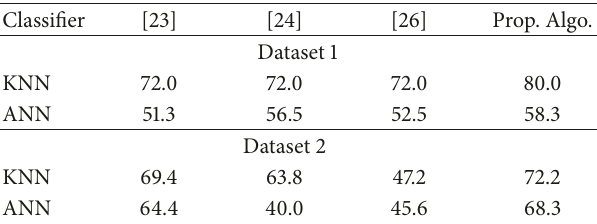
Table 3: Accuracy for 80 and 20 percent training and testing data.